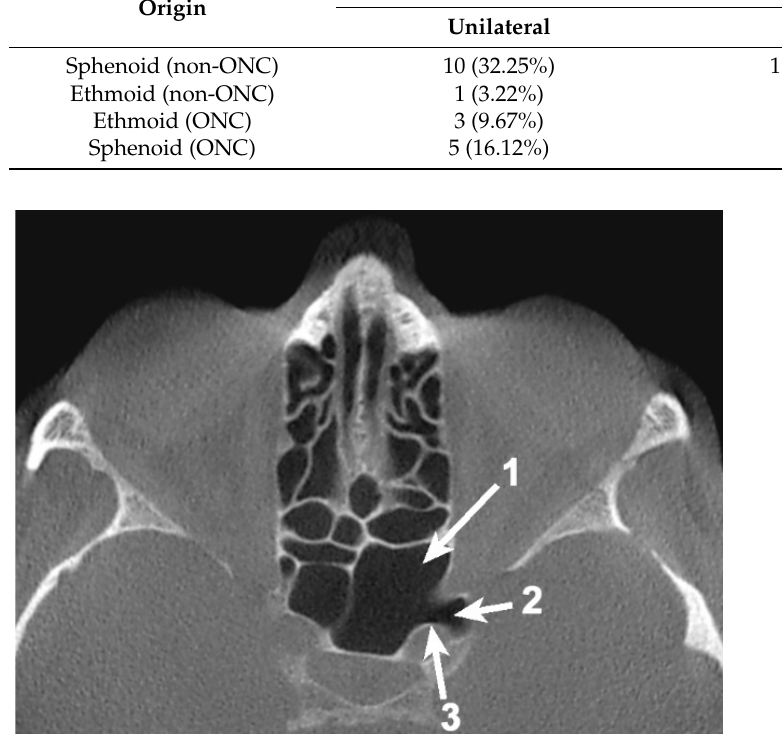
Figure 1. Axial CBCT slice at the level of the left anterior clinoid process (ACP), demonstrating the unilateral pneumatization of the ACP via the optic strut (OS) from the sphenoid sinus. 1. Sphenoid sinus; 2. Pneumatized ACP; 3. Pneumatized OS.